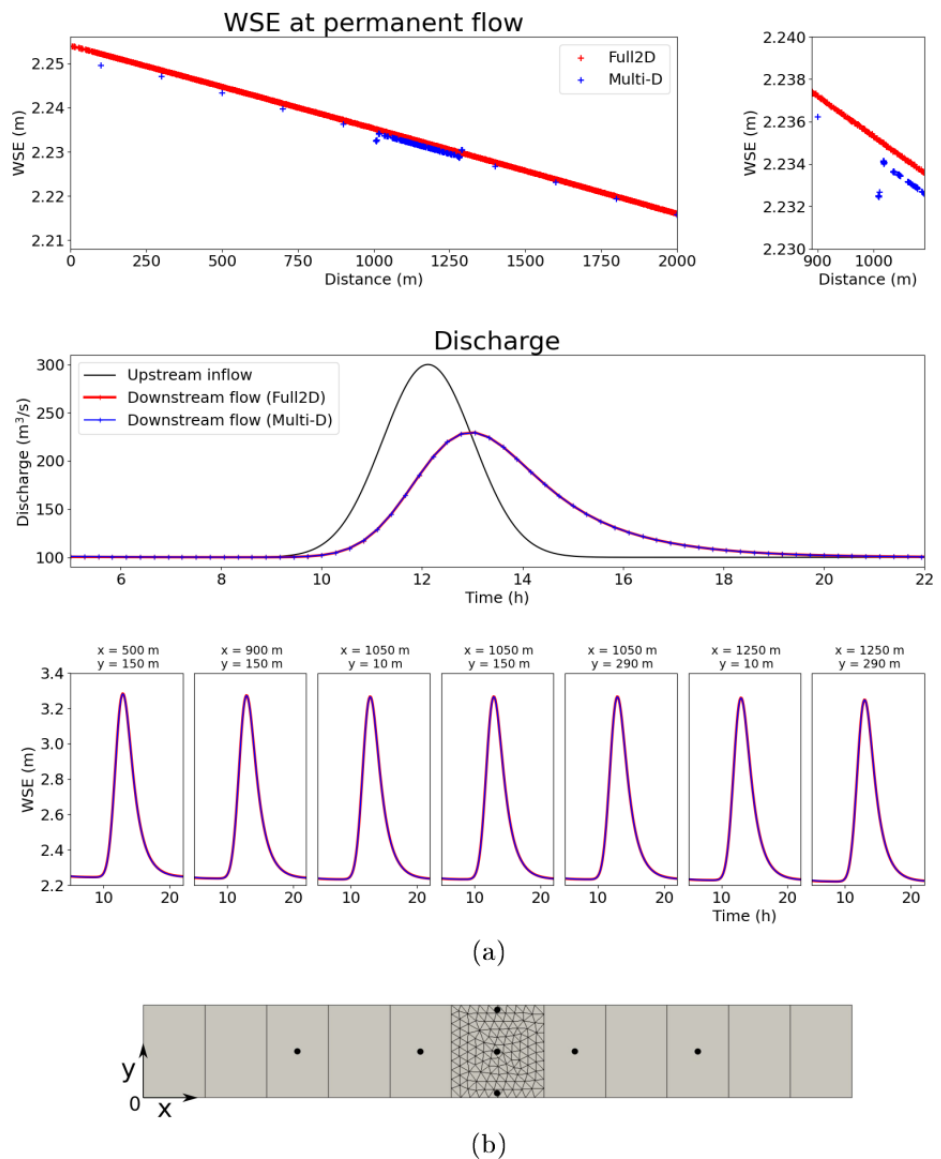
Figure 6. Multi-D straight channel case results with second-order scheme. The flow is subcritical with a maximum Froude value of 0 . 06. (a) Top: waterlines for a permanent flow of 100m 3 s − 1 : reference 2D waterline (red); waterline for the mesh in (b) (blue);he total misfit at the 1D–2D upstream interface (at 1000m) is around 10 − 3 m, for a relative misfit < 0 . 15% of the local depth. Middle: upstream discharge during sample varied flow event (blue); downstream simulated flow for the considered meshes (total overlap; red/blue). Bottom: WS elevation observations for the varied flow event (total overlap). (b) Multi-D mesh. Station locations are noted as blue dots.